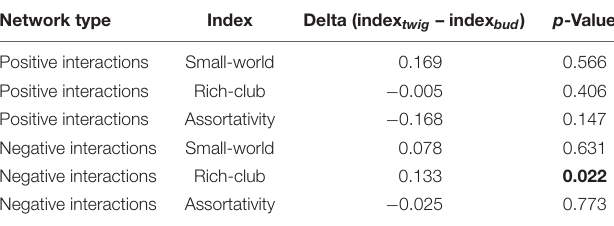
TABLE 3 | Statistical comparison of mycobiome interactions based on the positive and negative co-occurrence networks of fungi–fungi taxa. Network